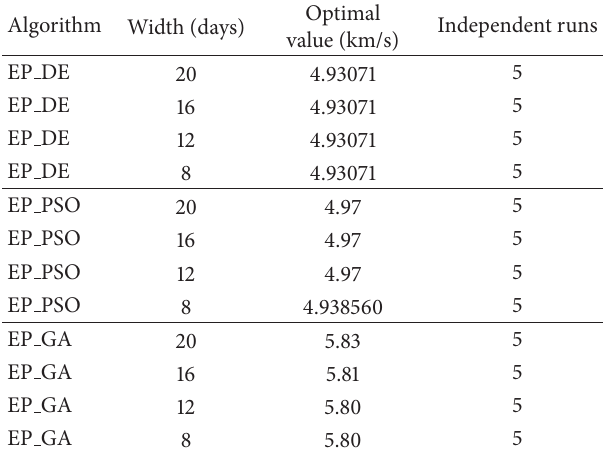
Table 10: Relationship between width of partition and optimal value.